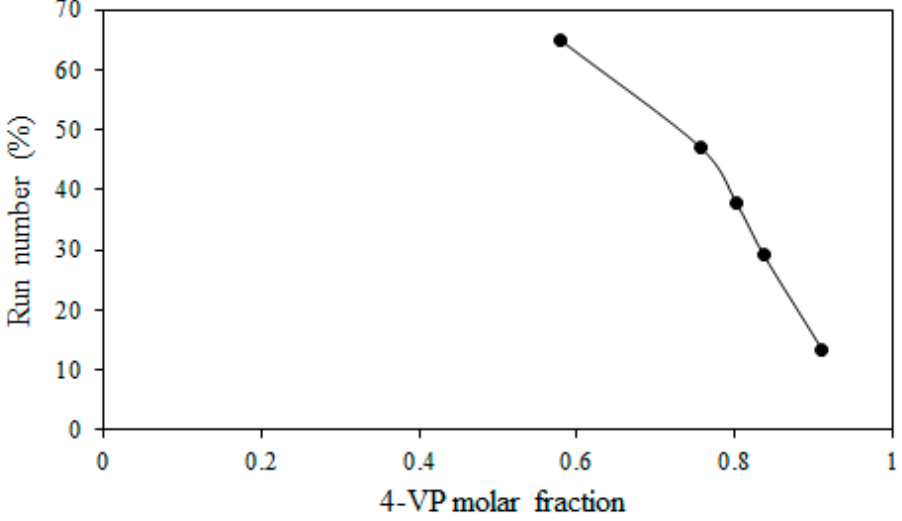
Figure 4. Variation of run number with 4-VP mole fraction in grafting of 4-VP/1-VIm mixture onto ETFE film. ETFE